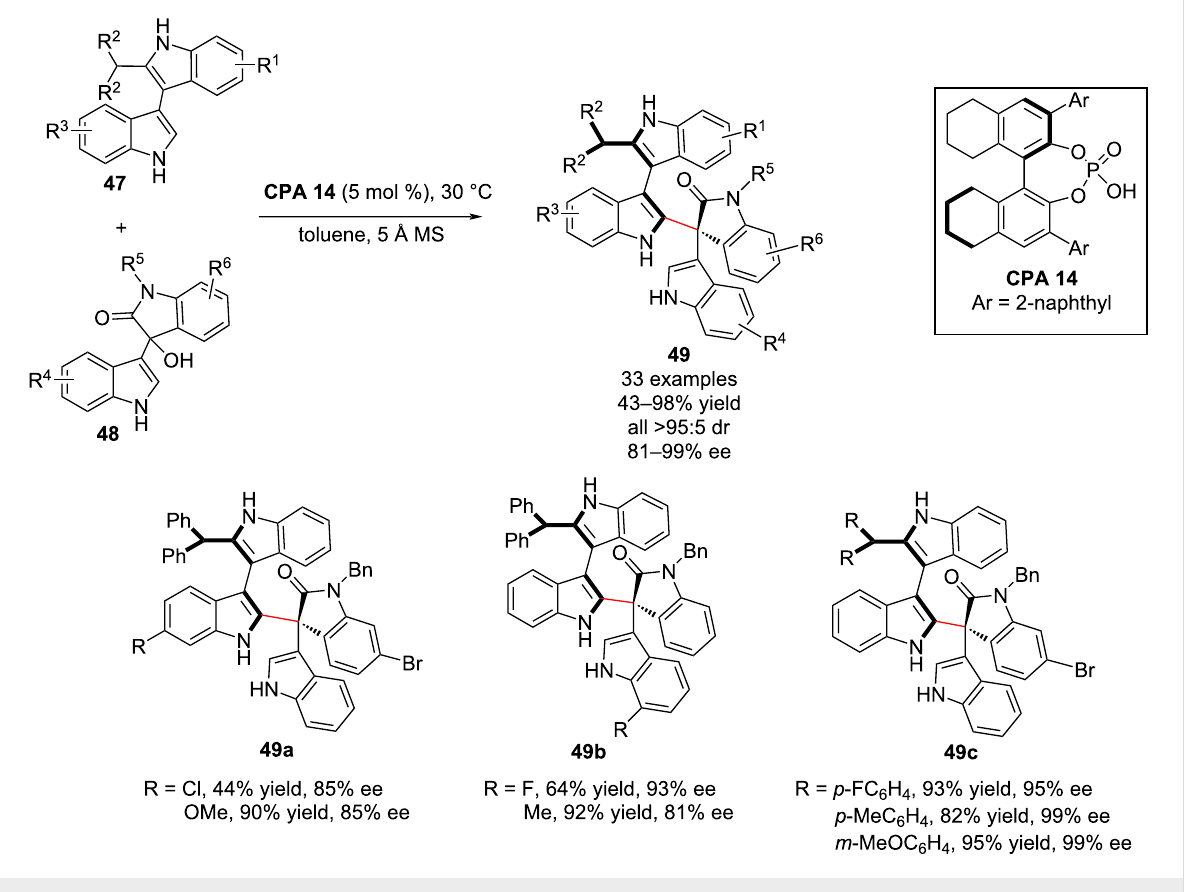
Scheme 16: Enantioselective synthesis of axially chiral 3,3’-bisindoles